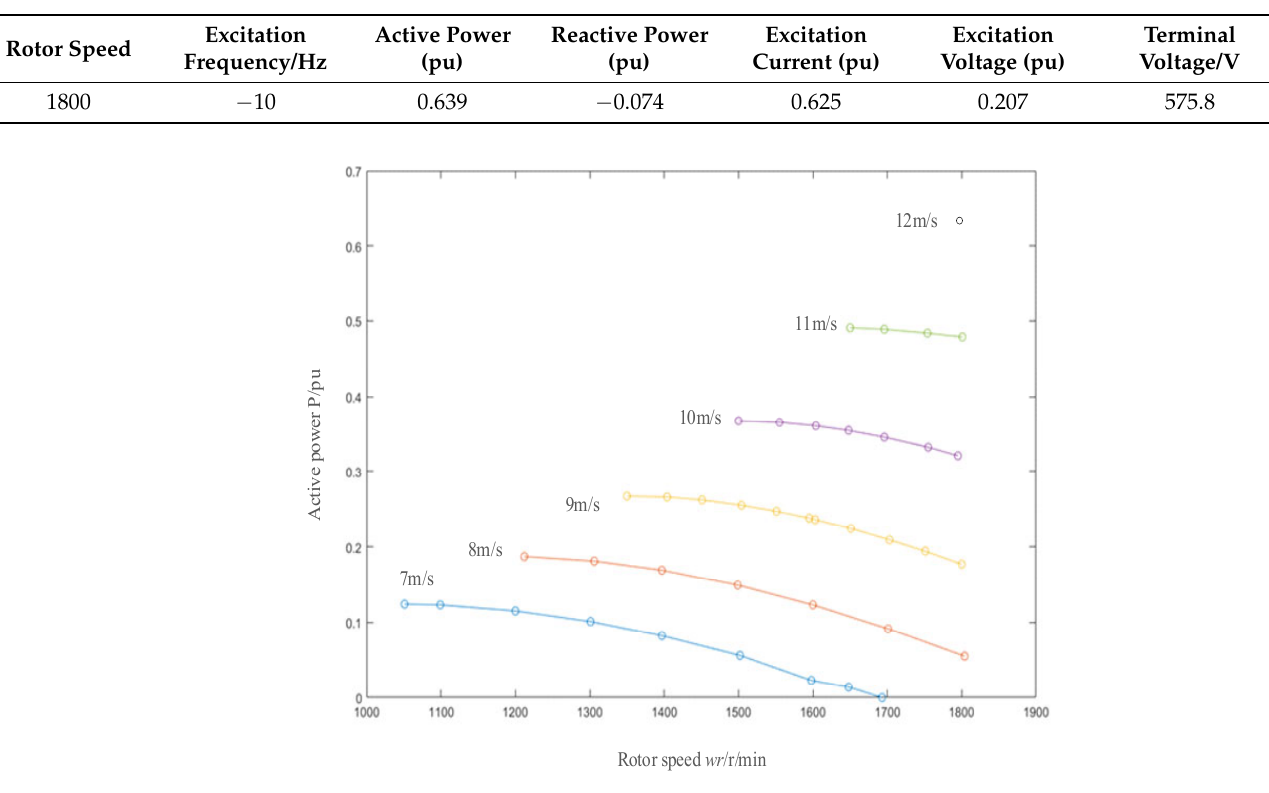
Figure 8. Transient frequency characteristics of doubly fed induction generator.